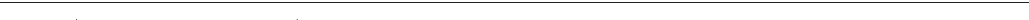
FIGURE 4 | transfer of 10 3 Sh2d1a − / − TCR75 CD4T cells (SAP − / − ; n = 5). Gated cells in middle column of representative dot plots show percentage of enriched CD19 + ve B cells binding H-2K d tetramer; right column shows percentage of GC-specific tetramer bound CD19 + ve B cells. (B) Histogram (left)—absolute numbers of splenic H-2K d -specific B cells (x 10 4 cells per mouse) enumerated; histogram (right)—percentage of H-2K d -specific B cells expressing FAS hi GL7 + ve GC phenotype. Data represents mean ± S.E.M, with each dot representing the biological replicate in a separate animal; * 1 P = 0.01, * 2 P = 0.004, * 3 P = 0.02 * 4 P = 0.004 Mann-Whitney test. (C) Total numbers of splenic CD4T cells (left histogram) and proportion displaying PD1 + CXCR5 + T FH cell phenotype (right histogram) as determined by flow cytometry analysis at indicated time points following transplantation of Tcrbd − / − recipients with a BALB/c heart graft and reconstitution with 10 3 WT TCR75 CD4T cells. Representative flow cytometry plot of unchallenged, but adoptively transferred (with 5 × 10 5 TCR75 CD4T cells) BL/6 Tcrbd − / − mouse (left) and transplanted WT reconstituted recipient